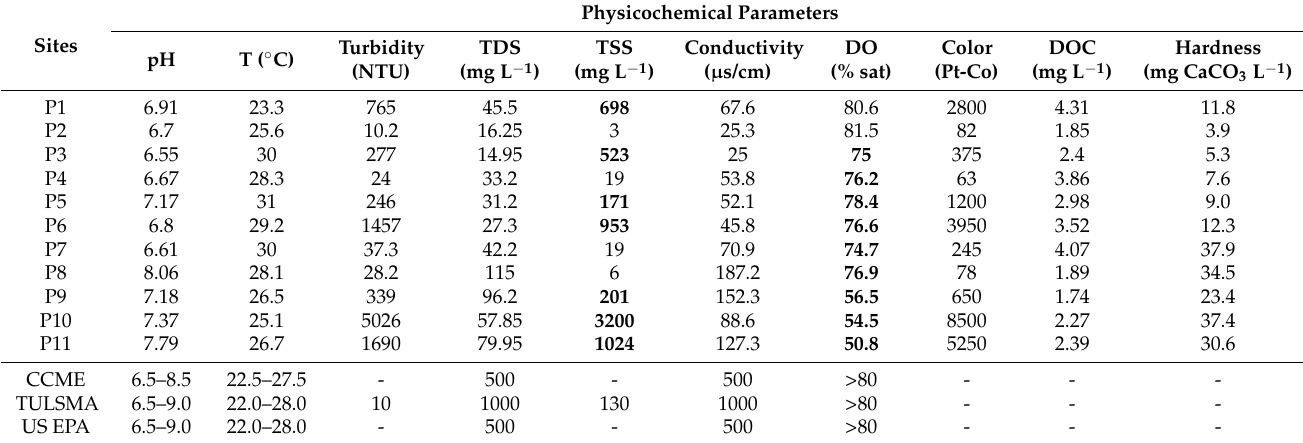
Table 1. Physicochemical parameters measured in the different sampling sites (see Figure 1 for site location). Values highlighted in bold are above (TSS) or below (DO) the thresholds for the Water Quality Criteria for the Protection of Aquatic